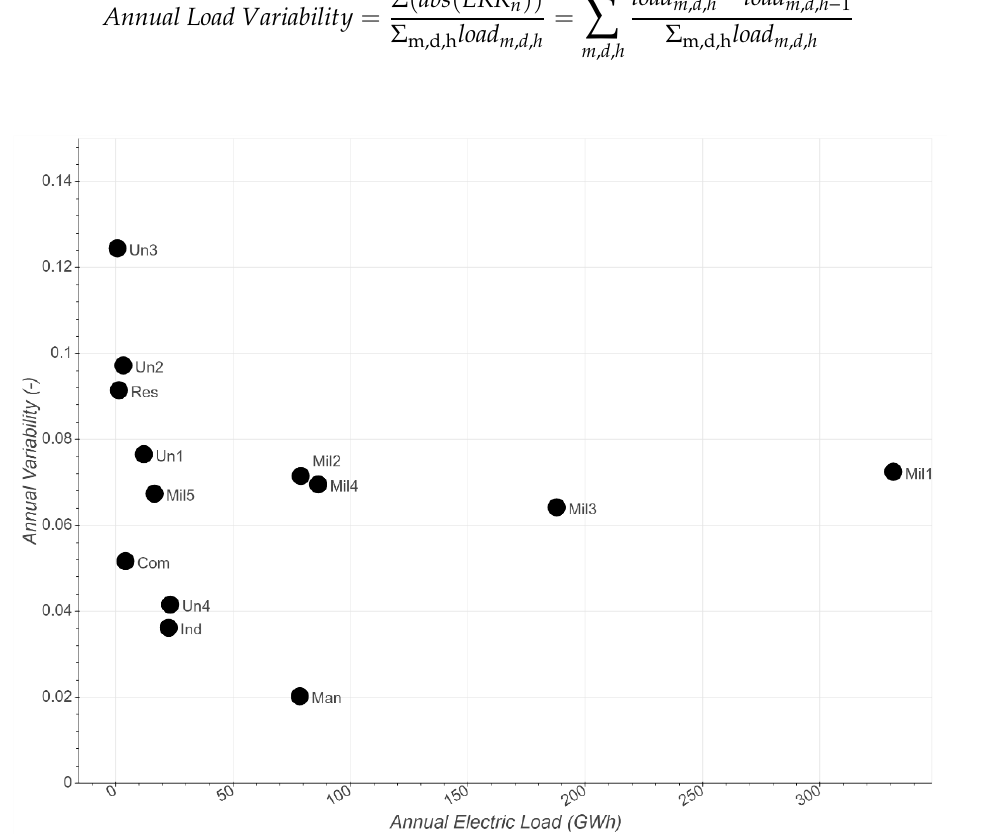
Figure 6. Summary of electric load data for all cases as a function of annual electric load (GWh) and load variability (-) expressed as the sum of the absolute values of all 1 h power changes normalized by the total annual load.